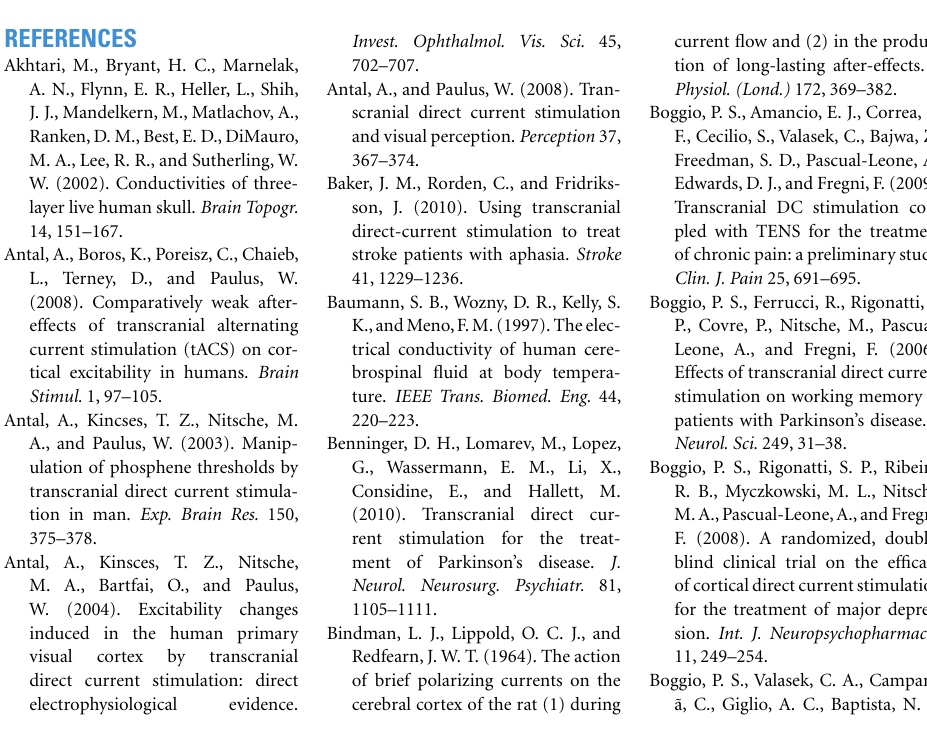
FIGURE 6 | Current flow during tACS. When current is applied sinusoidally, the direction of current flow flips back and forth by 180˚ for every half-wave. Let us consider the left stimulation electrode. During the positive half-wave, it represents the anode of a tDCS stimulation with